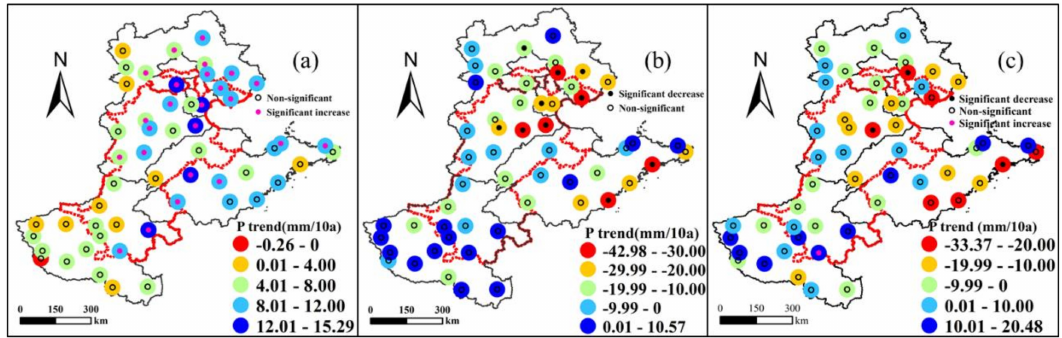
Figure 7. The spatial distribution and statistical significance of the trends in the precipitation (P) of the ( a ) winter-wheat growing season; ( b ) the summer-maize growing season and ( c ) the annual basis. Table 6. The province-wide, funnel area, and regional statistics for the wheat, maize, and annual precipitation average trend. P (mm/10a)